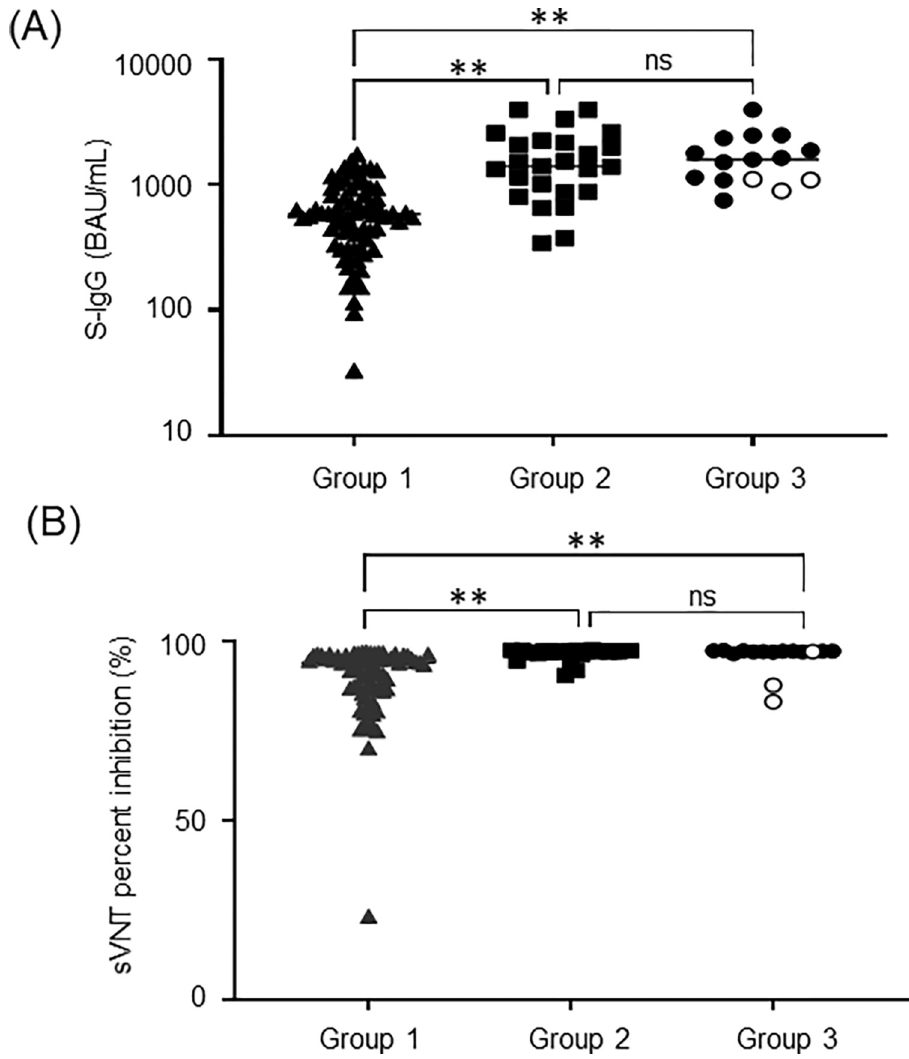
Fig 5. Distribution of VITROS S-IgG and cPass sVNT values in participants after second